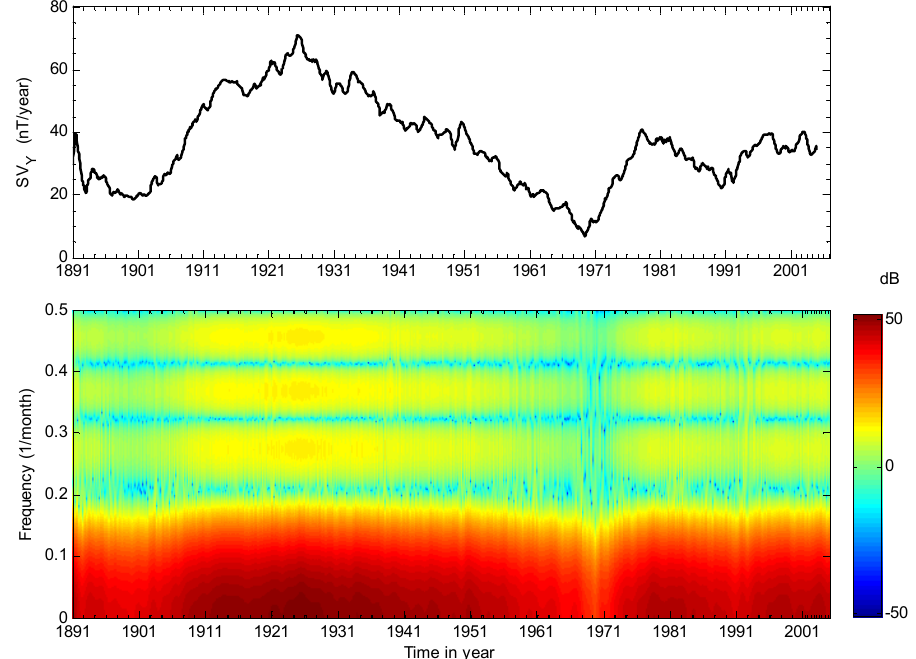
Fig. 4. The monthly series of SV Y (upper panel) produced by 12-month running mean for NGK observatory (1890–2005) and its spectrogram (bottom panel).